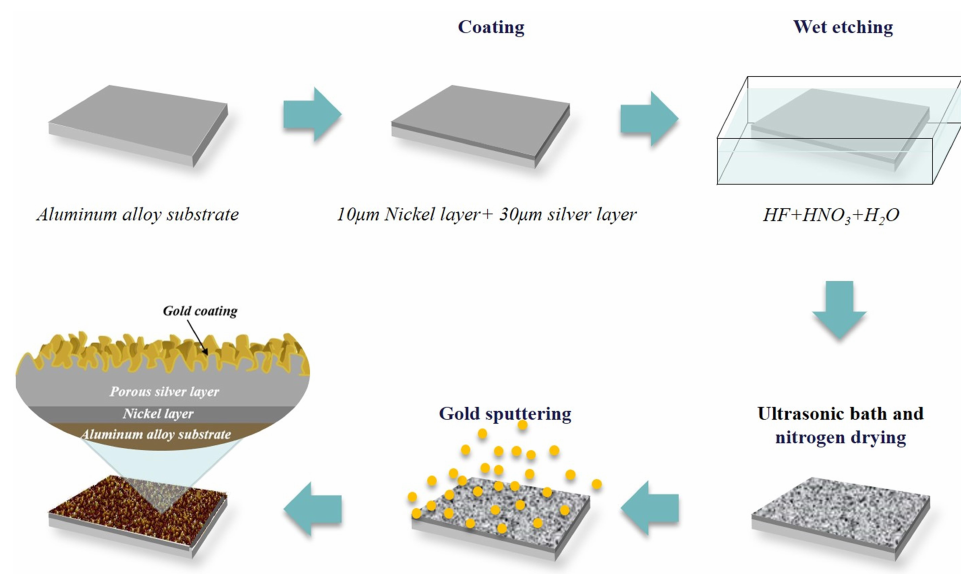
Figure 1. Schematic diagram of the sample structural evolution throughout the whole process. Table 1. The labels for the schemes of experimental process parameters.